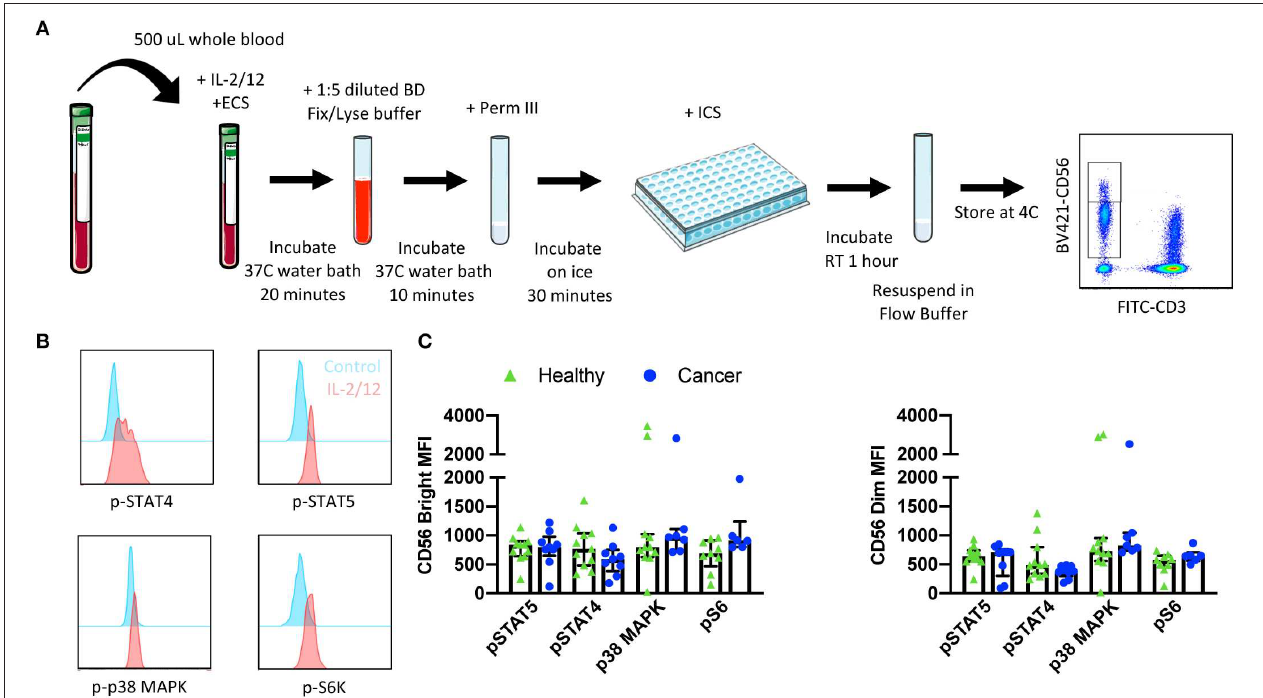
FIGURE 4 | Whole blood signaling protein methodology, gating strategy, and quantification. Whole blood was collected from patients and 500 µ L was aliquoted per receptor panel. After a 15-min incubation with IL-2/12 stimulation and the desired receptor panel, lyse/fix buffer was added and incubated for 10min before blood was spun down. Cells were washed, resuspended in Perm III Buffer, and incubated on ice for 30min before being spun down and resuspended in an intracellular staining mix. Cells were then incubated for an additional hour at room temperature prior to being resuspended and assessed by flow cytometry (A) . The lymphocyte population was gated on before excluding doublets and dead cells. CD45 + CD14 − CD56 Bright / Dim CD3 − cells were gated on to assess signaling protein phosphorylation (B) . The relative level of expression (MFI) of phospho-proteins STAT5, STAT4, p38 MAPK, and S6 was assessed in healthy donor ( n = 13) and cancer patient ( n = 9) samples (C) . Shown are the median values ±